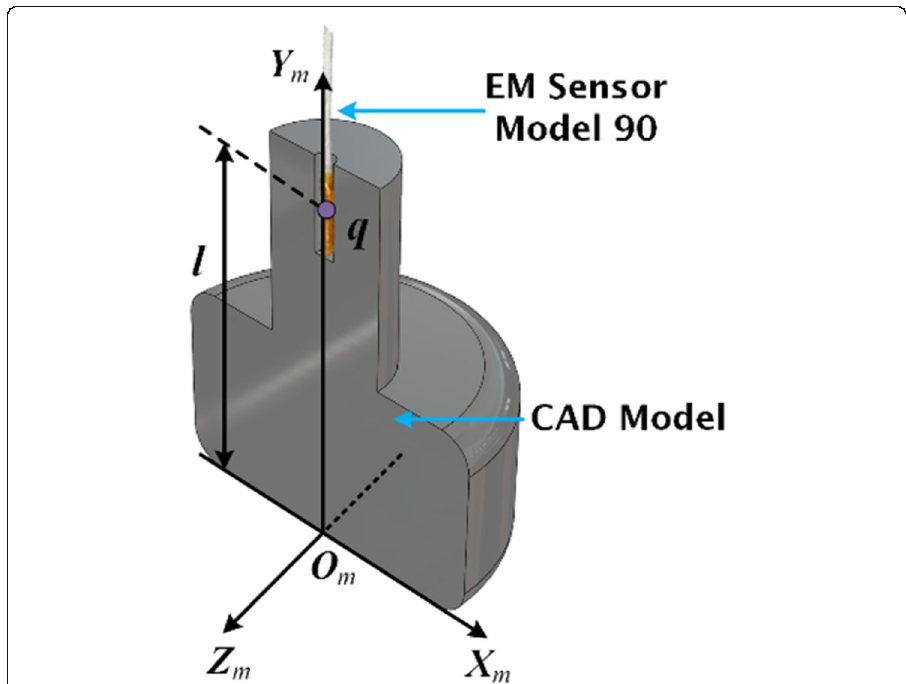
Fig. 6 The estimated position of EM sensor model 90 in the coordinate frame of the CAD